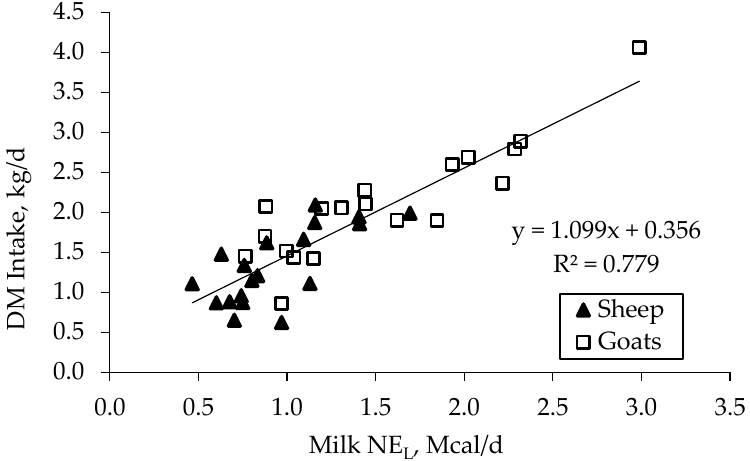
Figure 5. Relationship between individual daily DM intake and daily milk NE L of the Saanen goats and Sarda ewes during the digestibility trial carried out in mid-lactation.